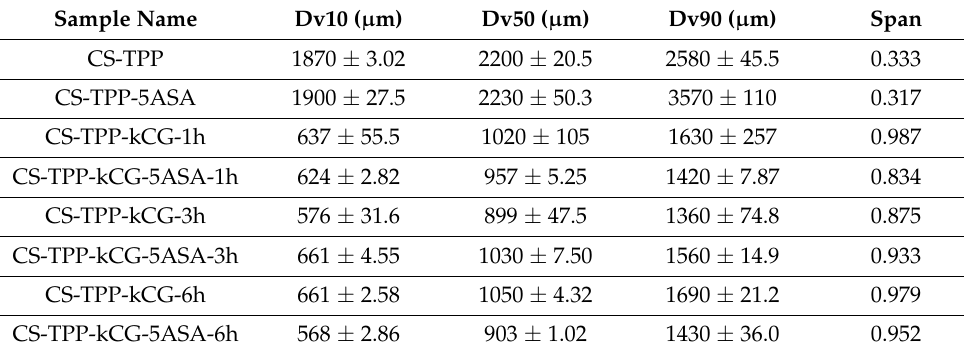
Table 2. Particle size and span value of the hydrogel particles.